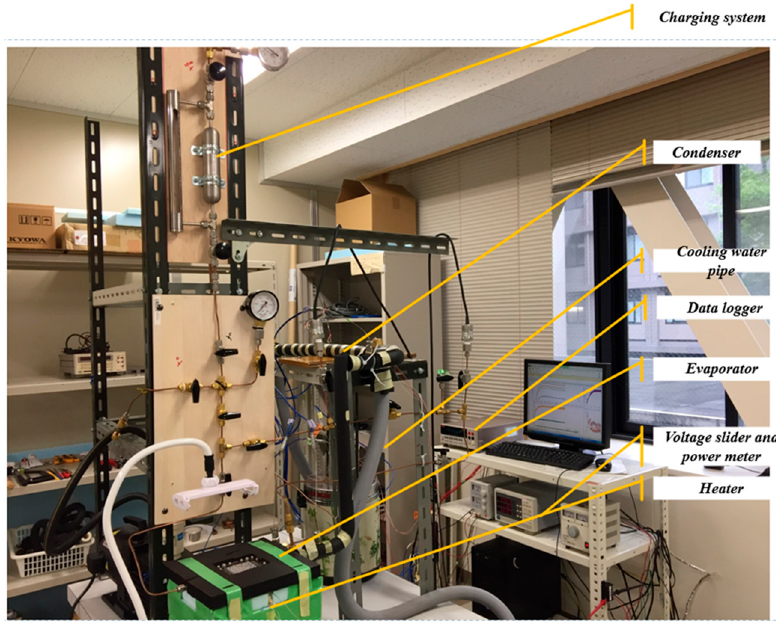
Figure 4. Photograph of the real experimental setup under gravity-assisted conditions. Table 3. Main parameters of the LHP.